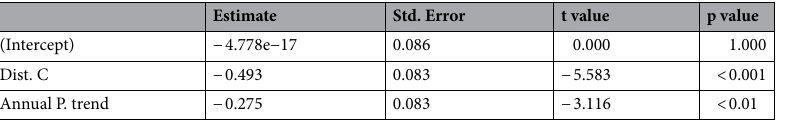
Table 1. Summary of the GLM coefficients to evaluate the effect of geographic and climatic variables on the mean time to extinction ( T mean ) of the metapopulation. Variables initially included were: distance to the metapopulation centroid (Dist. C), distance to the nearest subpopulation (Dist. N), minimum January ( T jan ) and maximum August ( T aug ) temperatures (mean values of the period 2000–2018), annual precipitation (mean 2000–2018) and the trends of the three climatic variables (as the slope of a linear regression of the period 2000–2018). Only the significant variables remaining after sequential model simplification are shown (see details in text).